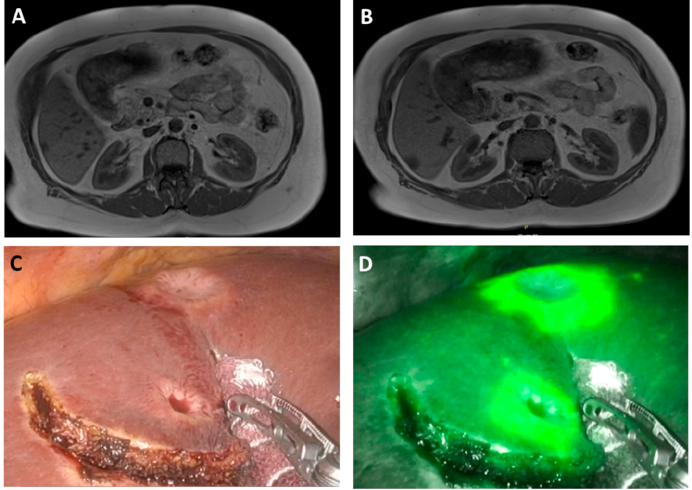
Figure 1. Intra-operative robotic image in white light ( C ) and intraoperative near-infrared ( D ) image of CRLM (rim phenomenon) with corresponding preoperative T-weight MRI-scans ( A+B )